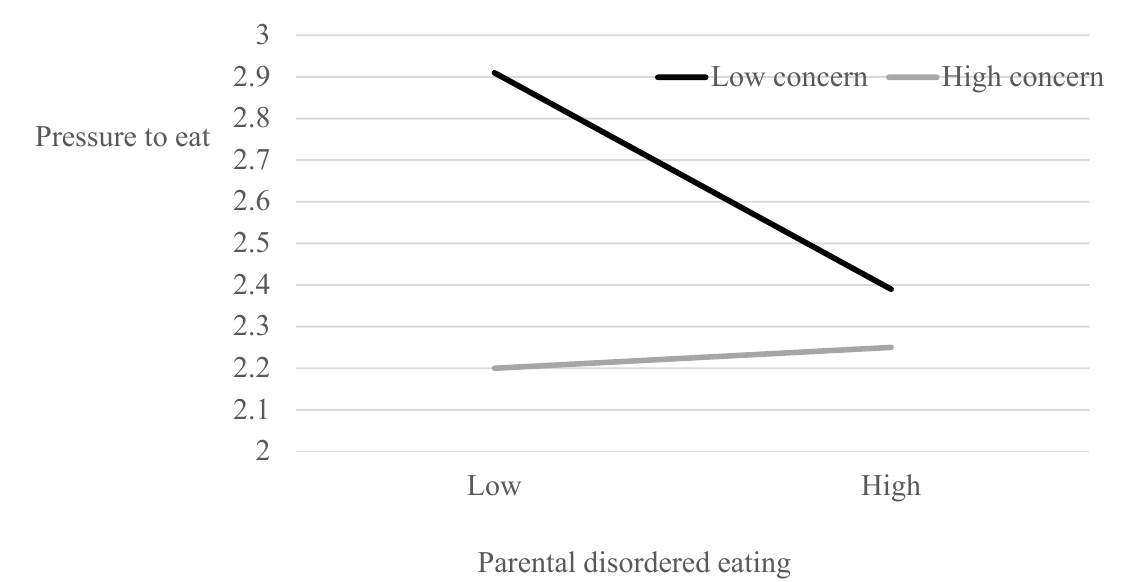
Figure 2. Interaction between parental disordered eating and concern for child’s weight on pressure for child to eat.